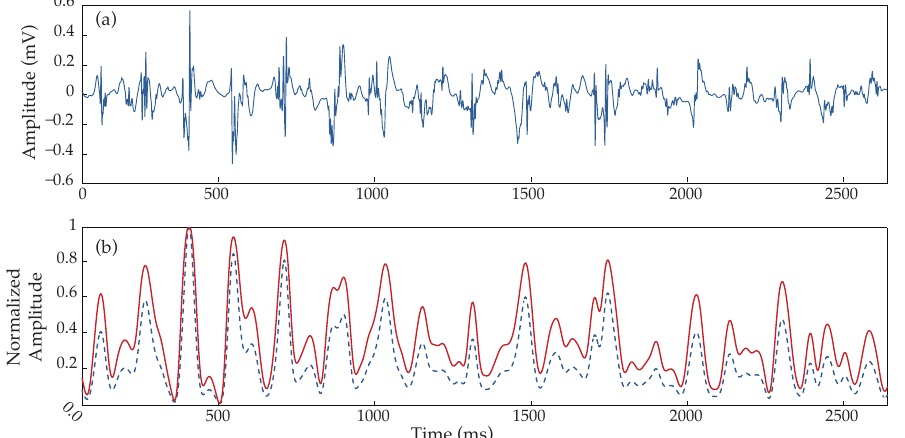
Figure 6. Hyperbolic tangent application over an example type III AF EGM. ( a ) Raw electrogram, ( b ) corresponding response before (blue dashed line) and after (continuous red line) the use of the hyperbolic tangent. Notice the different responses depending on the wave’s height, generating a higher increment for smaller than for higher